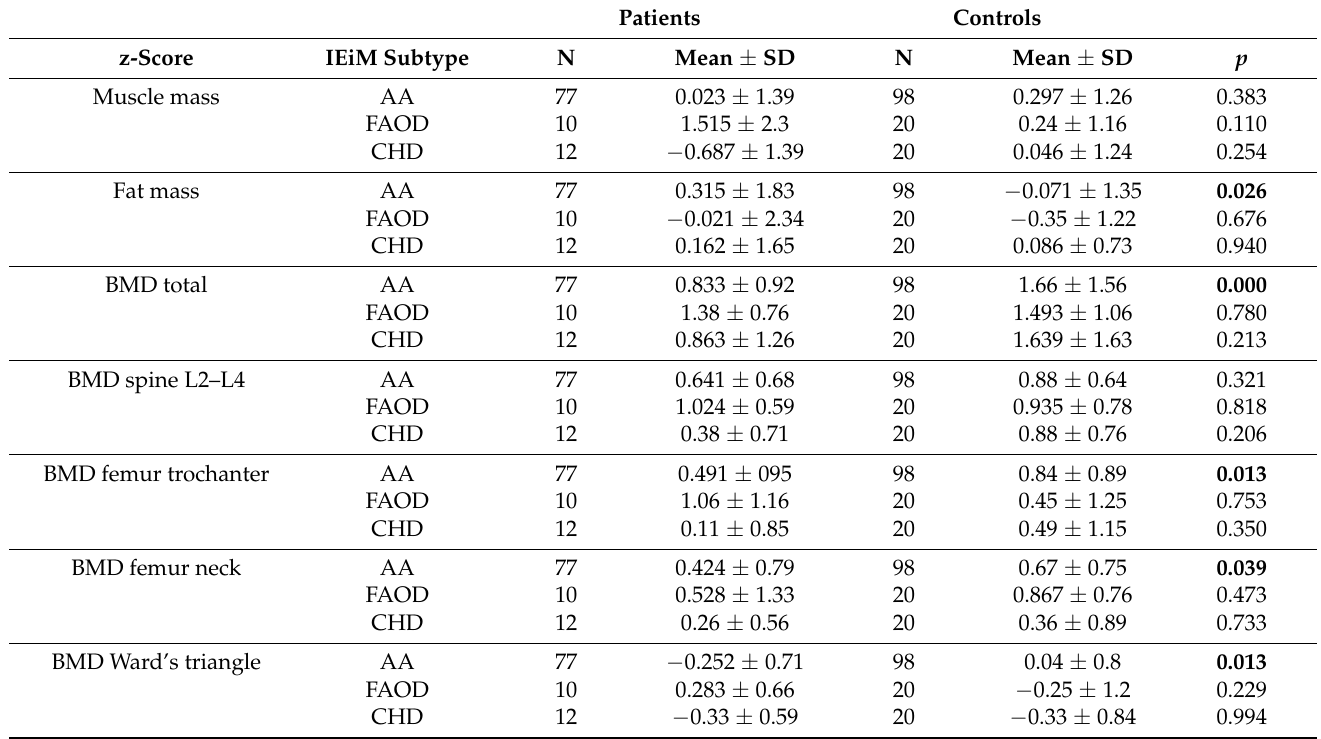
Table 6. Mean body composition z-scores measured by DEXA according to IEiM